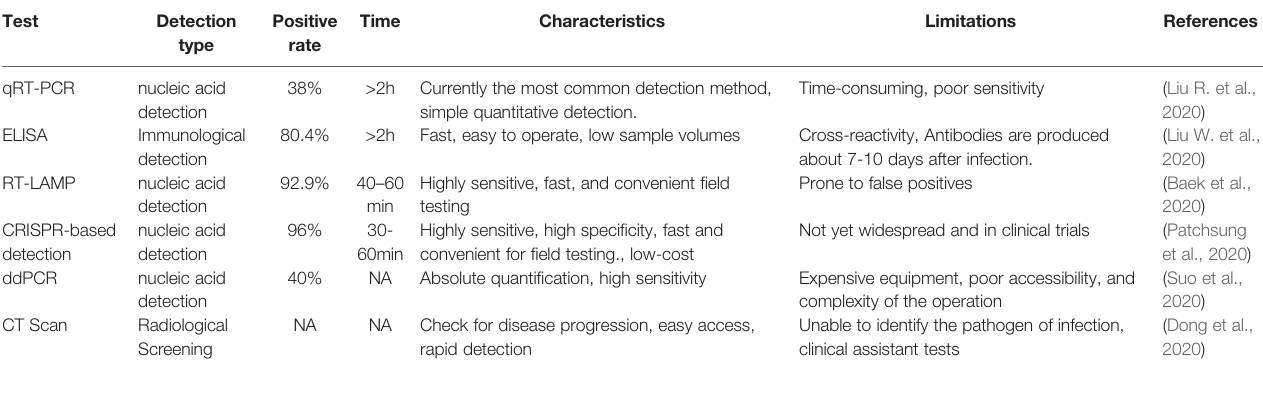
TABLE 1 | Available diagnostic methods for